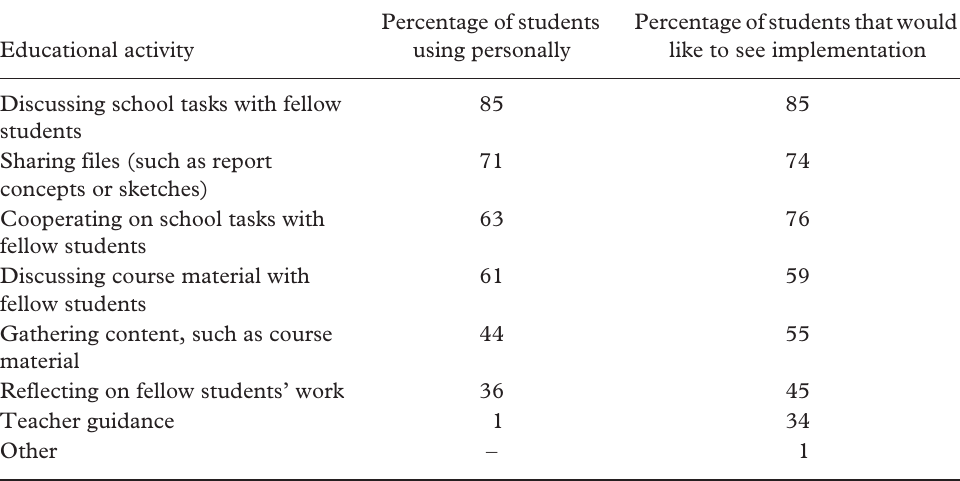
Table 3. Educational IM activities and demands of Dutch higher education